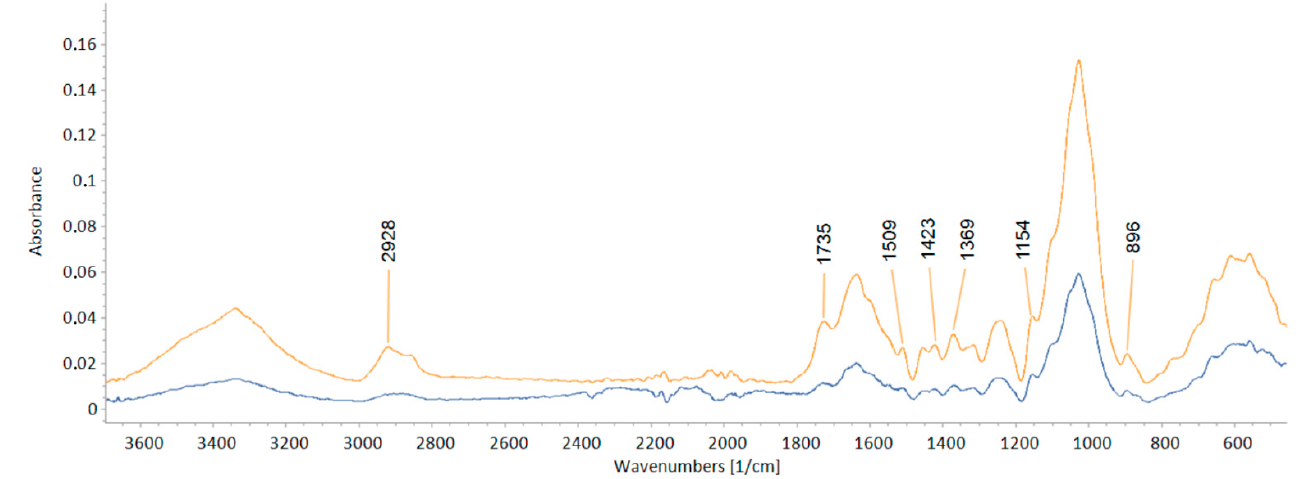
Figure 1. An example of FTIR spectra of particleboard before (blue line) and after (brown line) 20 weeks of deconvolution with P. ostreatus ; I–III—separated ranges of spectra; the selected wavenumbers are described in Table 1.